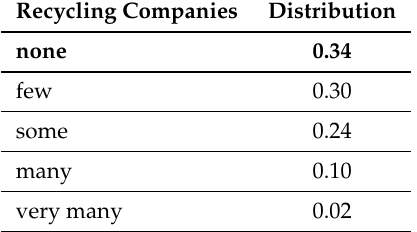
Table 15. Overall distribution of the categorical variable “recycling companies in the surroundings of the city”.